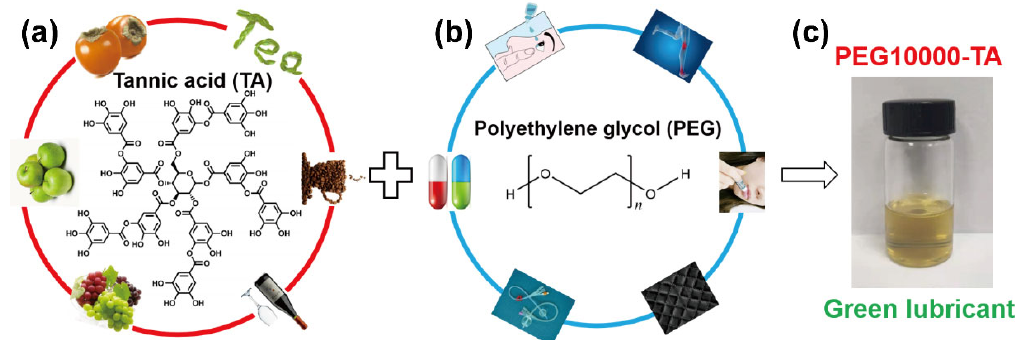
Fig. 1 Preparation of green liquid lubricant by using TA and PEG. (a) Chemical structure of TA and its corresponding sources. (b) Chemical structure of PEG and its applications. (c) Optical photo of PEG10000-TA green liquid